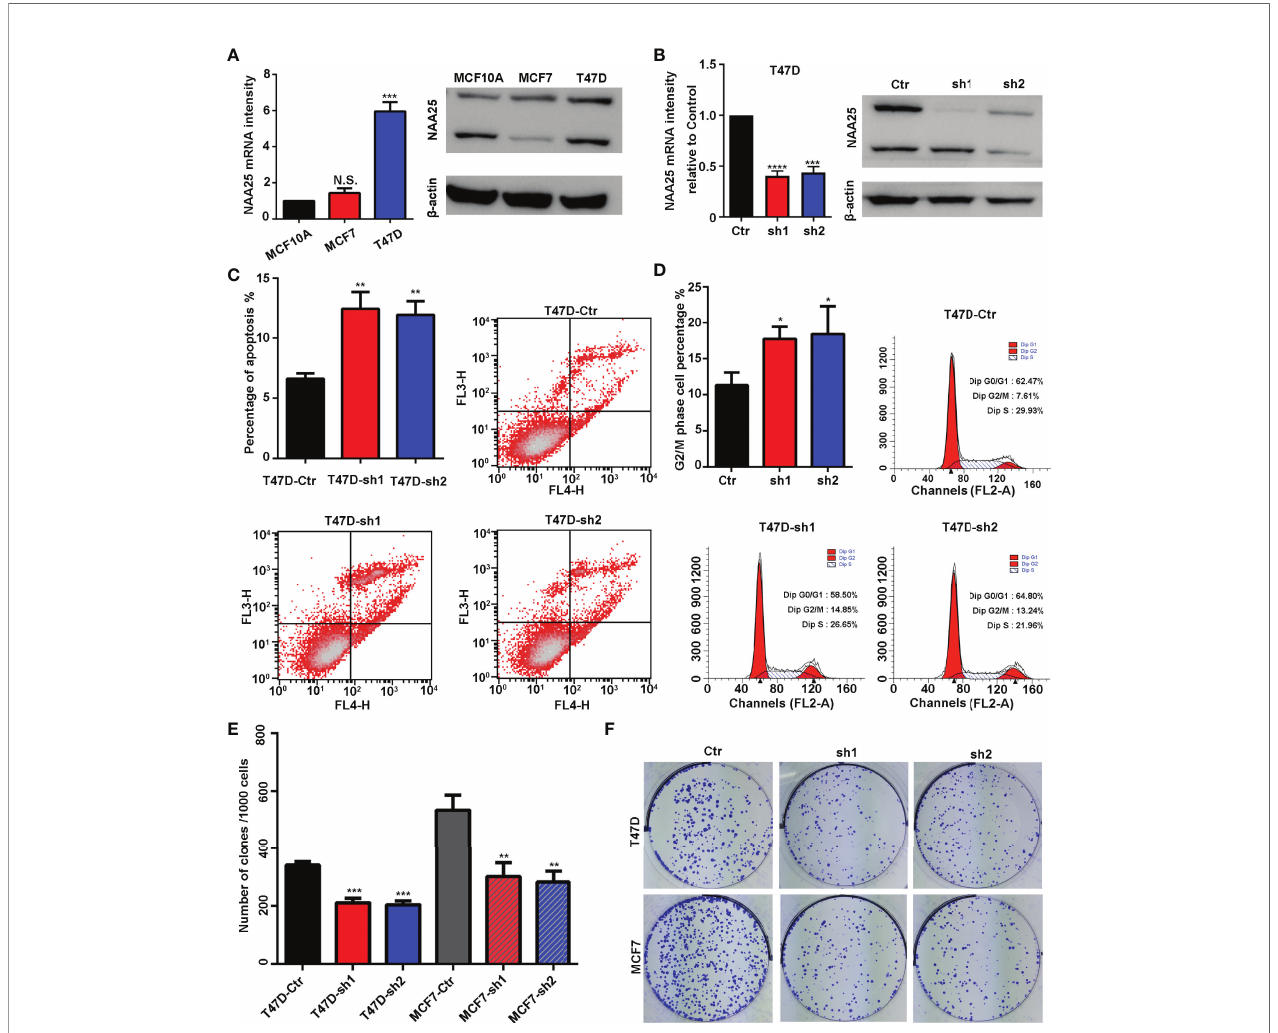
FIGURE 2 | NAA25 gene in fl uences cell apoptosis and the cell cycle in breast cancer. (A) RT-qPCR and western blot analysis of NAA25 gene expression in breast cancer cell lines (The two bands are all NAA25 .). (B) RT-qPCR and western blot analysis in the NAA25-de fi cient T47D cell line. (C) Cell apoptosis in the NAA25- de fi cient T47D cells. Compared to the Ctr group, NAA25 knockdown could increase cell apoptosis. (D) Cell cycle analysis of the NAA25-de fi cient T47D cells. Compared to the Ctr group, NAA25 knockdown induced G2/M cell cycle arrest. (E, F) Downregulated NAA25 reduced the clonogenic potential of breast cancer cells. N.S. p > 0.05; * p < 0.05; ** p < 0.01; *** p < 0.001 and **** p